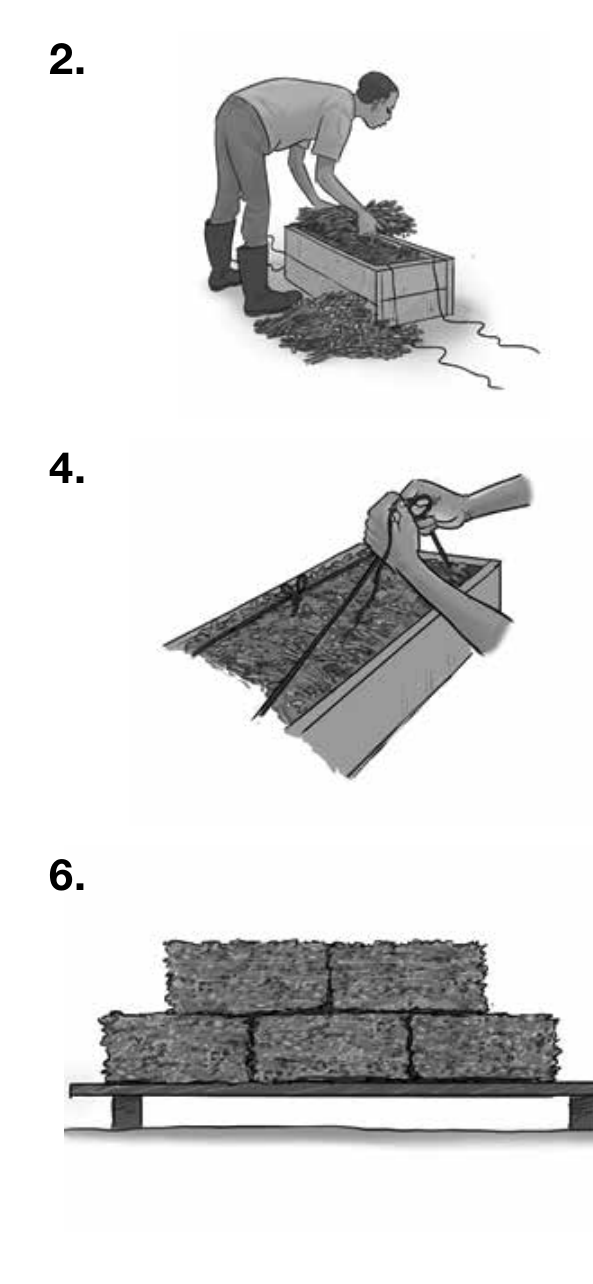
Figure 10: How to use a simple box